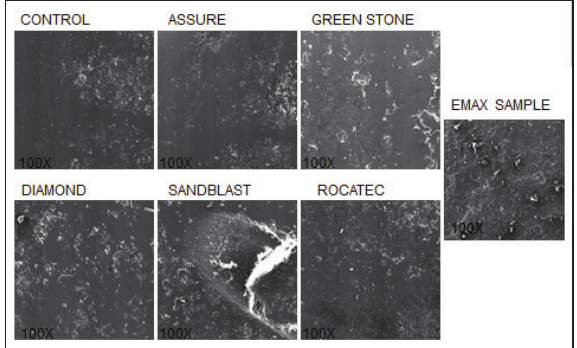
Figure 2. SEM images post-polishing under 100×